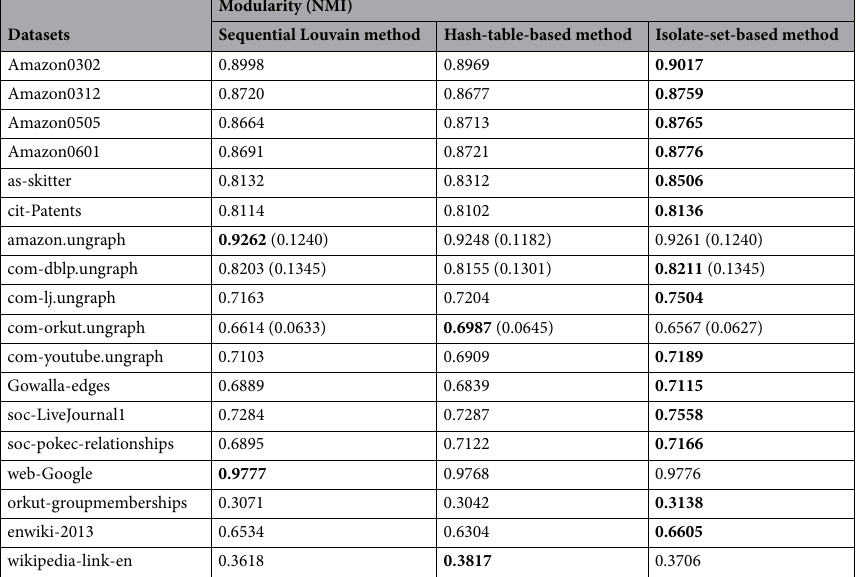
Table 3. Modularity of extended graph datasets. Significant values are in